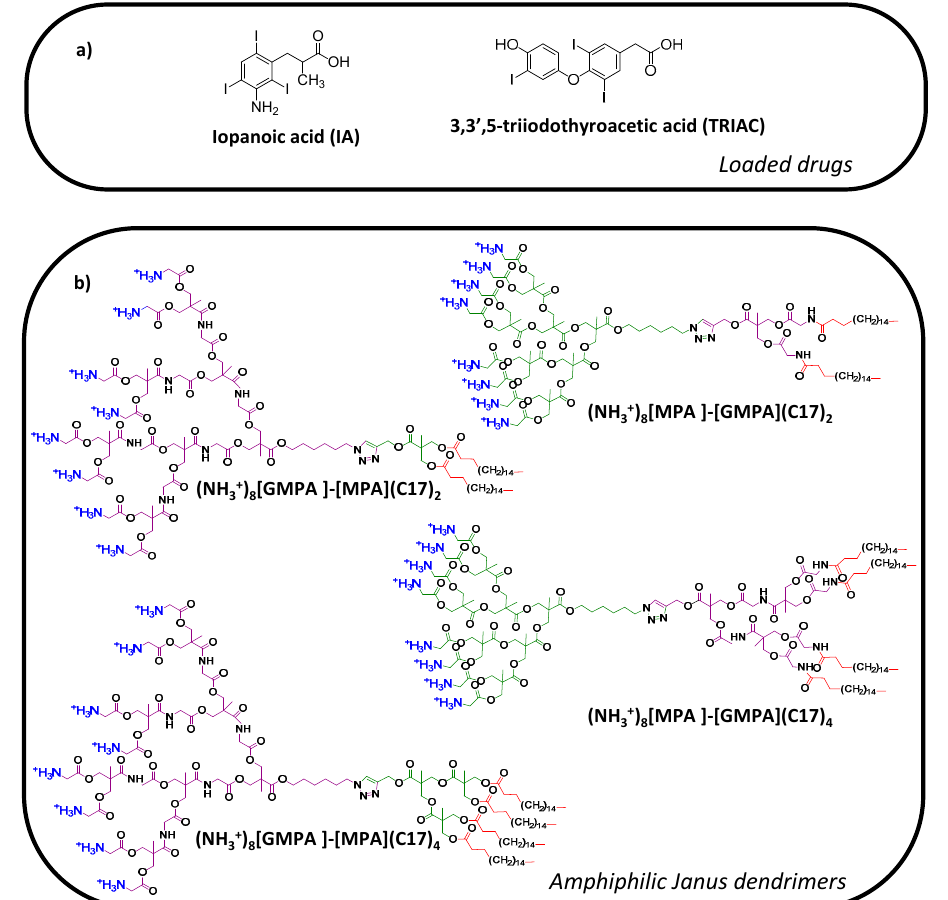
Figure 1. ( a ) Chemical structure of the drugs studied for anti-HCV therapy; ( b ) chemical structure of the amphiphilic Janus dendrimers.